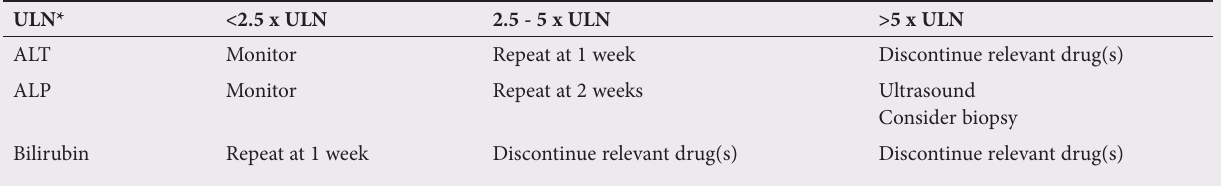
Table 12. Guidelines for managing hepatotoxicity ULN*